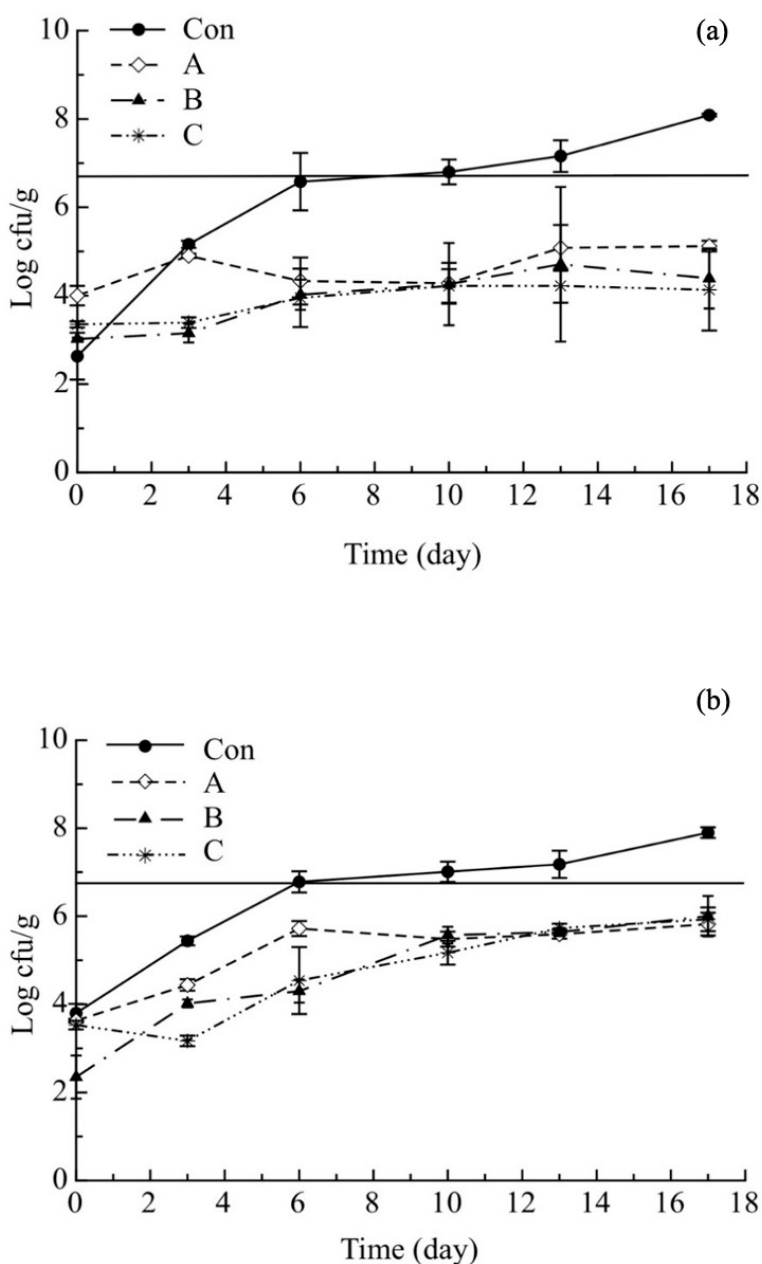
Figure 1. Evolution of total mesophilic ( a ) and psycrhrotrophic ( b ) bacteria in breaded cod sticks during storage at 4 °C. Data are presented as mean ± SD ( n = 2). Symbols: experimental data; Solid Line: threshold for microbial acceptability set to 5 × 10 6 log cfu/g. Con: sticks breaded with sole no active mix; A: sticks breaded with sole active mix; B: sticks breaded with pomegranate peel powder/no active mix; C: sticks breaded with pomegranate peel powder/active mix.